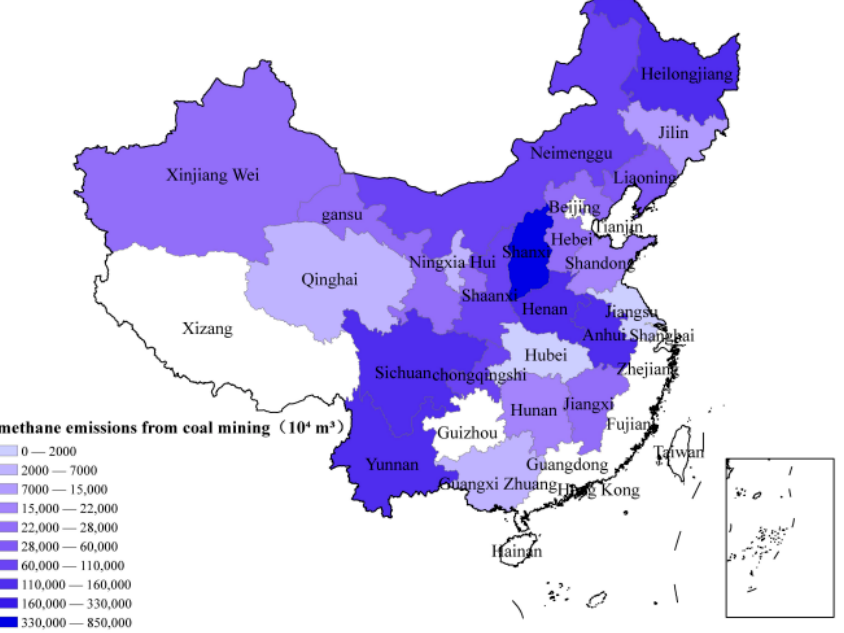
Figure 4. CH 4 emissions of coal mining industry in various provinces (Zhu, A. 2022